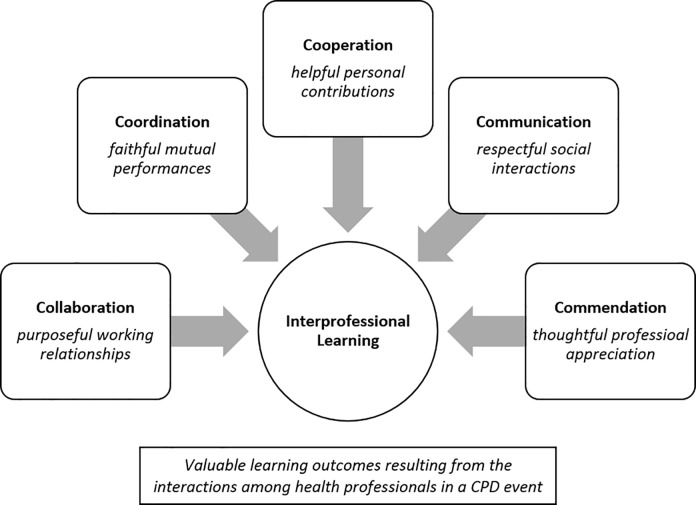
Identified IPL constructs as outcomes.